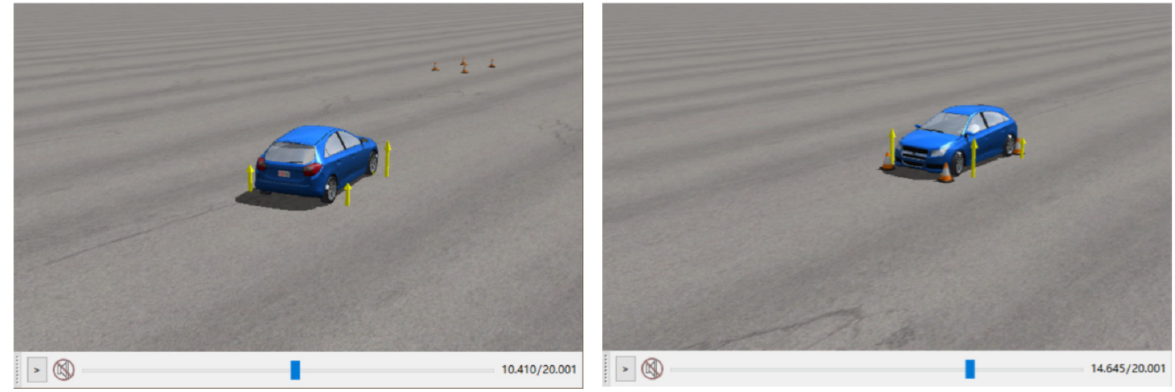
Figure 5. Drift parking